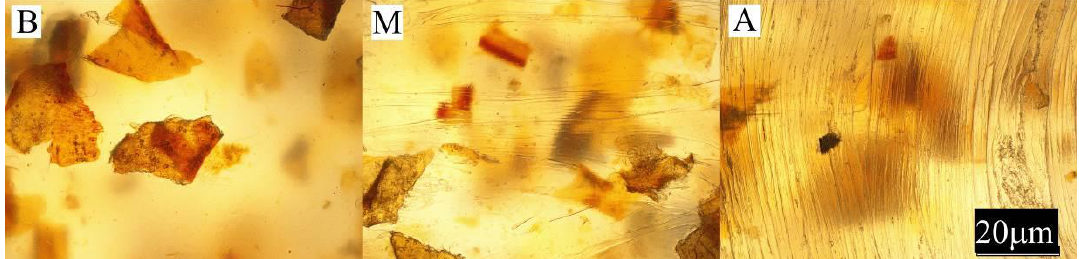
Figure 9. The appearance of individual parts of the injection moulding obtained with a 15% content of bran fraction with a grain size of 0.4–0.6 mm at measuring points A, M, B (the position of the points is marked in Figure 1).